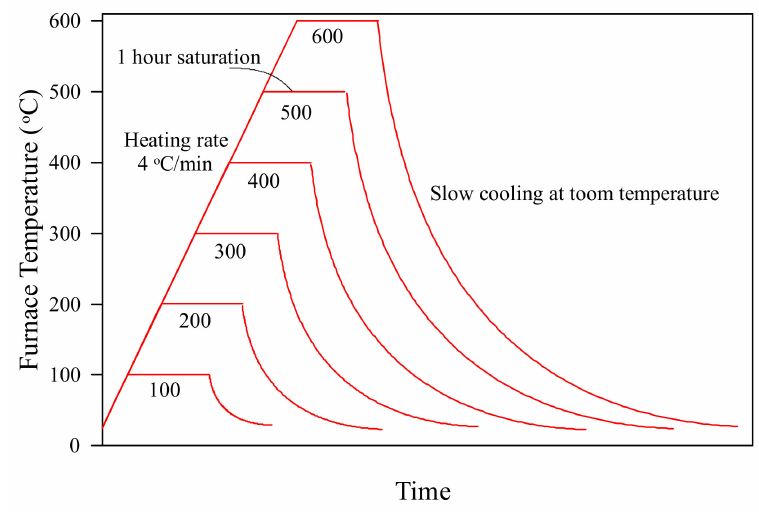
Figure 5. Heating and cooling regime of the electrical